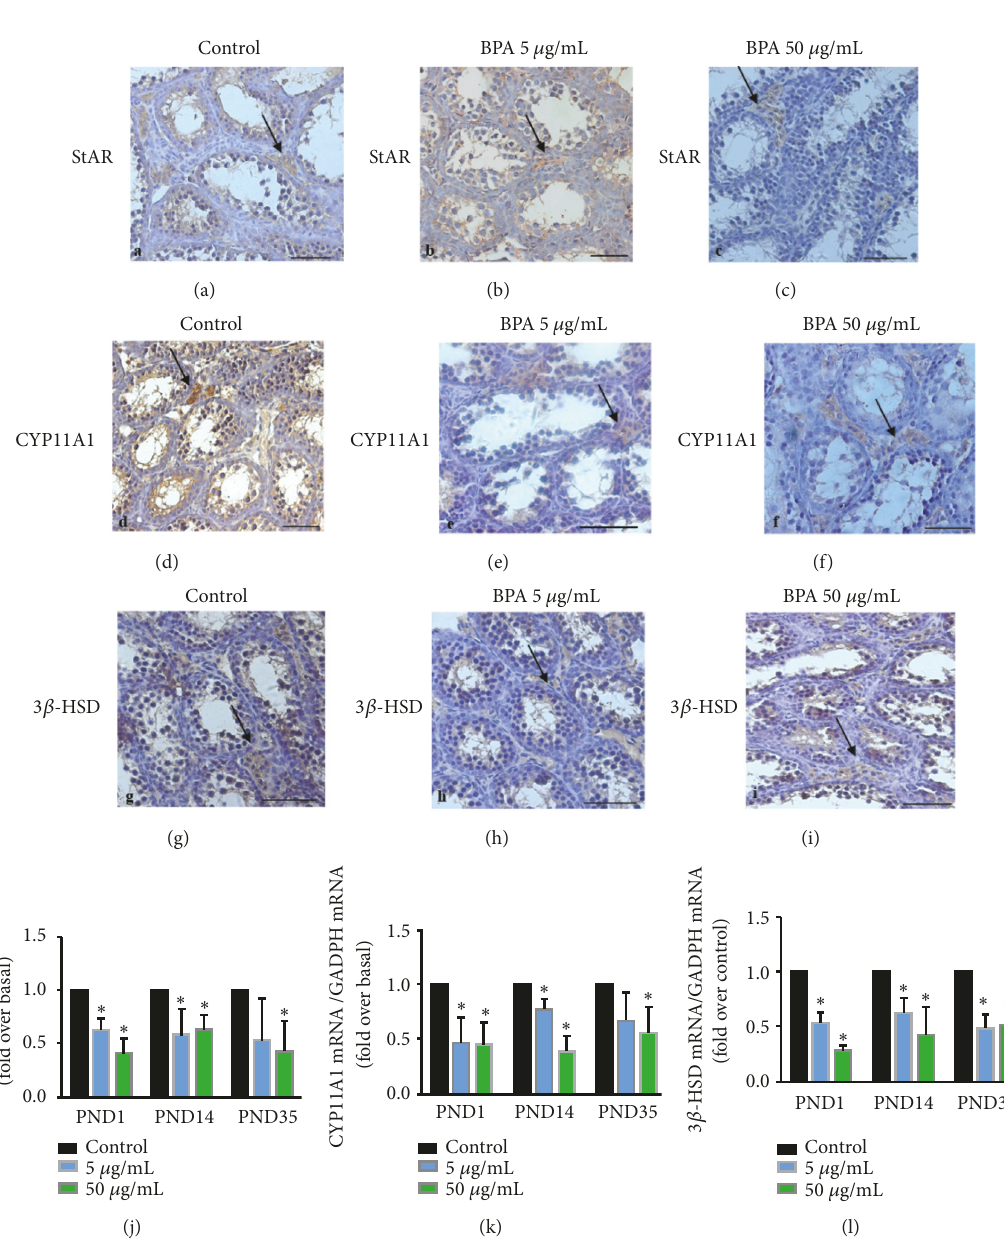
Figure 1: Immunohistochemistry and real-time PCR analysis for steroidogenic enzymes in testes of pups from female exposure to BPA at 5 𝜇 g/mL or 50 𝜇 g/mL throughout gestation. Immunohistochemical staining for StAR, CYP11A1 and 3 𝛽 -HSD in control and BPA- exposed pups on PND14. (a–c) Immunolocalization of StAR in the testis. (d–f) Immunolocalization of CYP11A1 in the testis. (g–i) Immunolocalization of 3 𝛽 -HSD in the testis. (j) Real-time PCR results of StAR in the testis. (k) Real-time PCR results of CYP11A1 in the testis. (l) Real-time PCR results of 3 𝛽 -HSD in the testis. Data present mean ± SD. N=3 per treatment group, with each n representing a different litter from a different female. Black arrow points to Leydig cells that show positive staining. The ∗ indicates a significant difference compared to control at P < 0.05. Bar = 50 𝜇